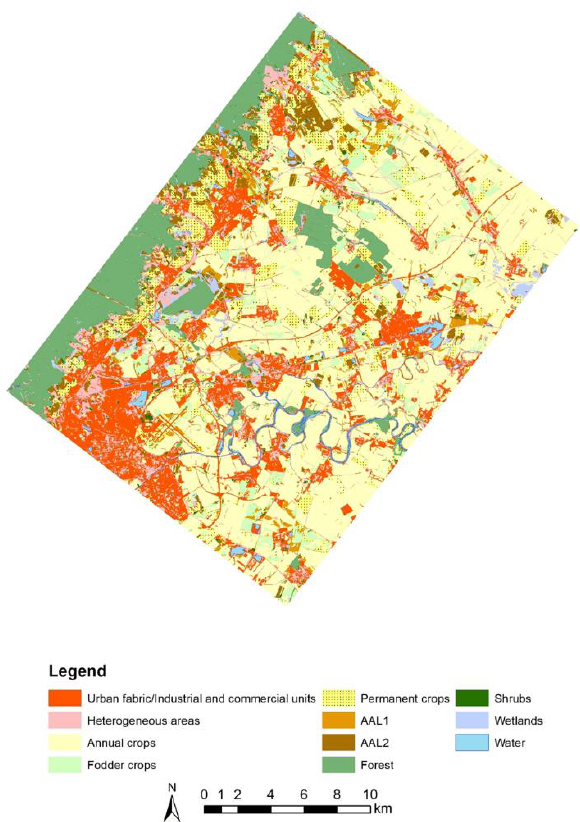
Figure 6. Abandoned agricultural land and LC/LU classes map